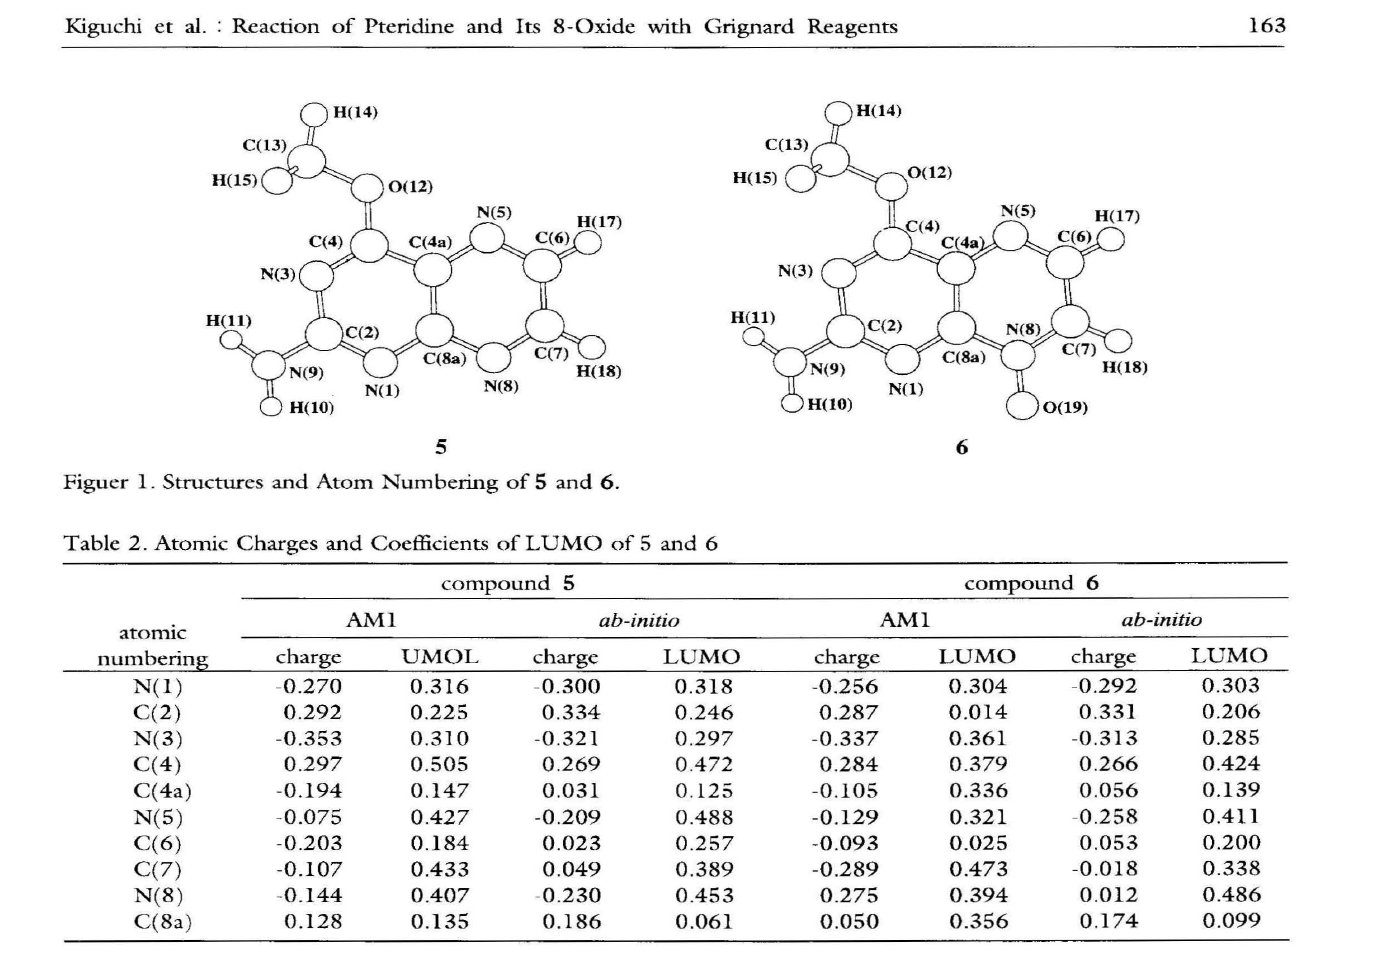
Figuer 1. Stnlctures and Atom Numbering of 5 and 6. Table 2. Atomic Charges and Coefficients of LUMO of 5 and